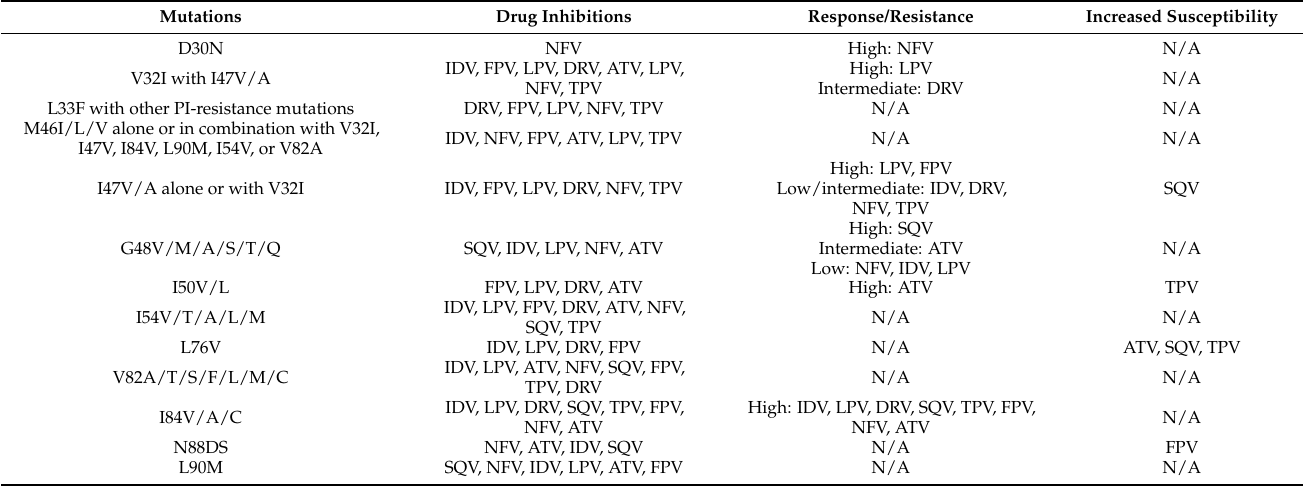
Table 8. Protease inhibitor mutation patterns that result due to PI